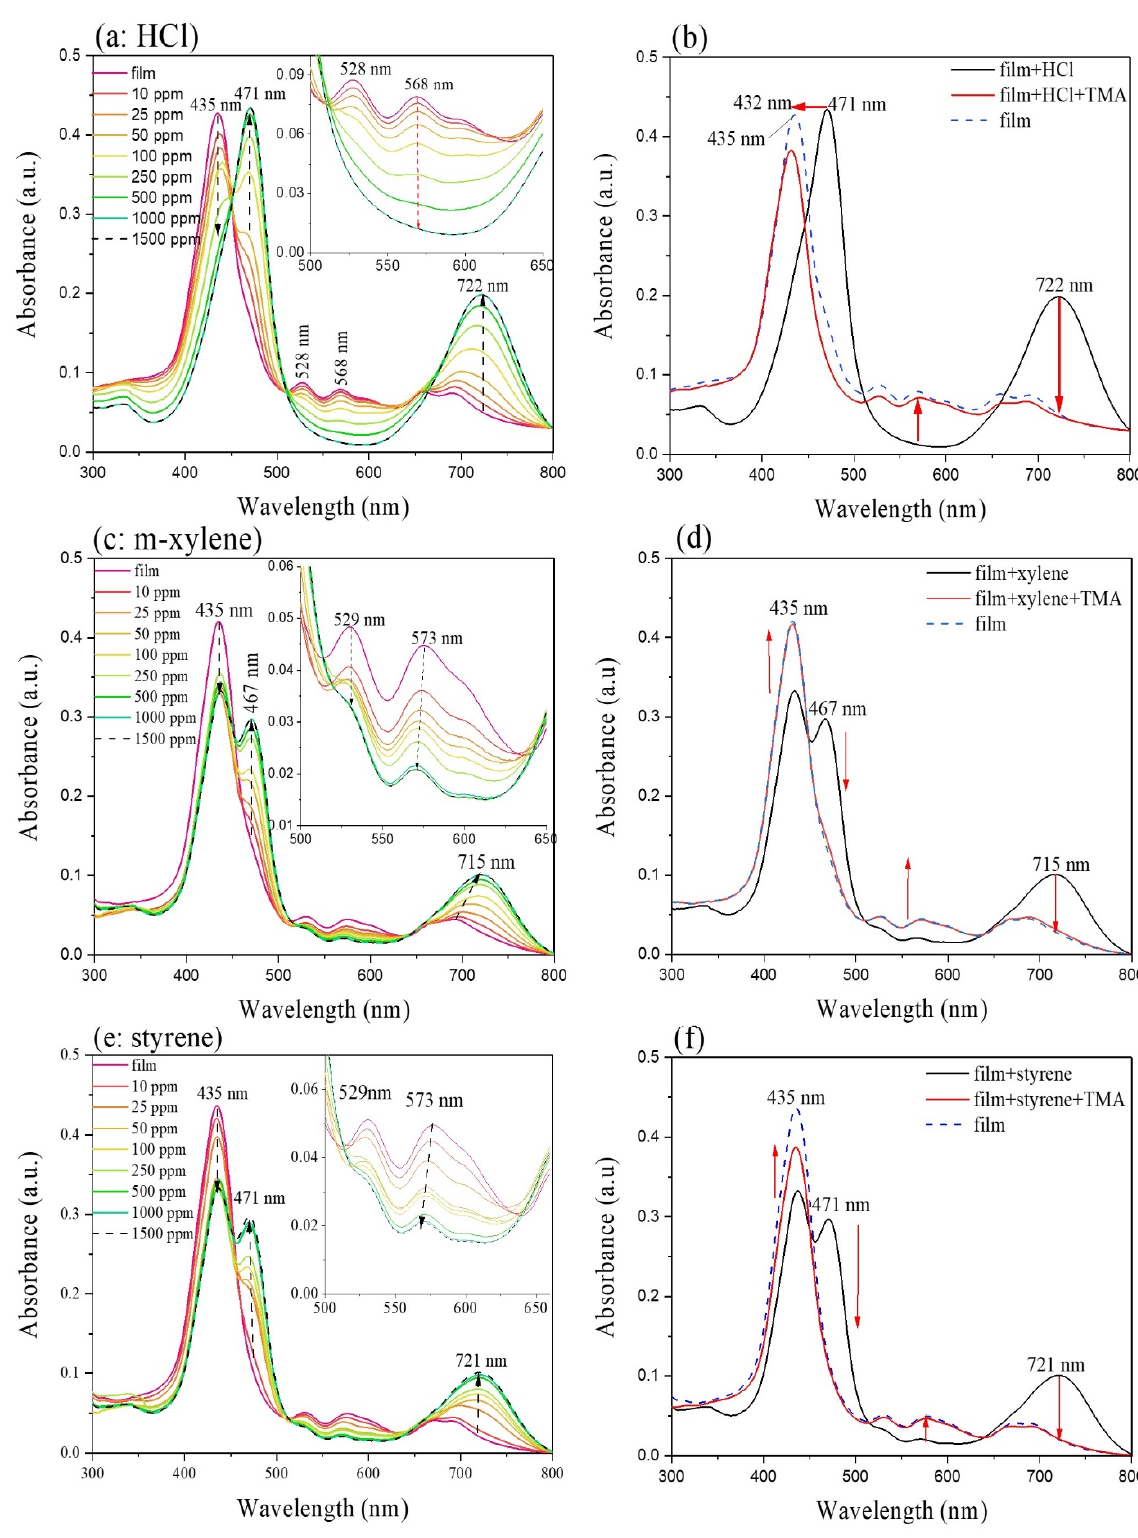
Figure 8. Absorption spectrum of PPc film ( a ) exposing with HCl vapor (10 ppm to 1500 ppm); ( b ) HCl-exposed-film recovery with trimethylamine (TMA) exposure; ( c,e ) exposing with m-xylene and styrene vapor (10 ppm to 1500 ppm); ( d,f ) m-xylene, styrene exposed-film recovery with trimethylamine (TMA) exposure The absorbance trend, as a function of gas concentrations of HCl, is reported in Figure 9a,b, which shows the absorbance trend of characteristic bands at 471 and 722 nm, and